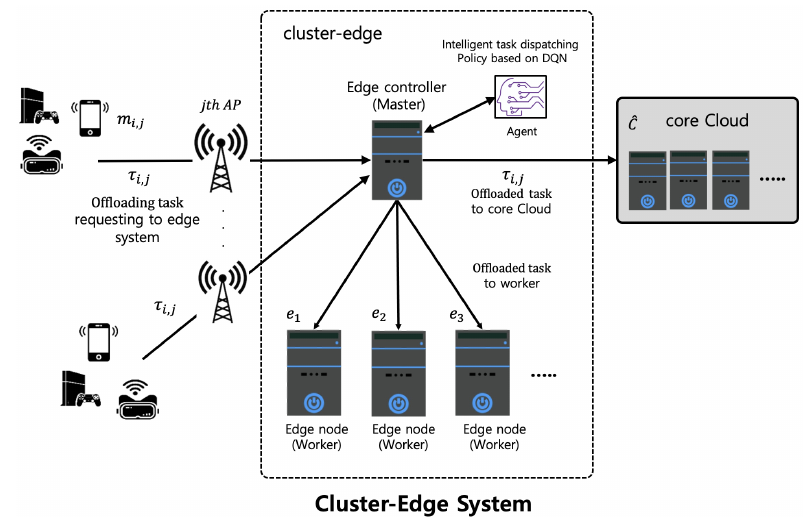
Figure 1. Cluster edge system-based network